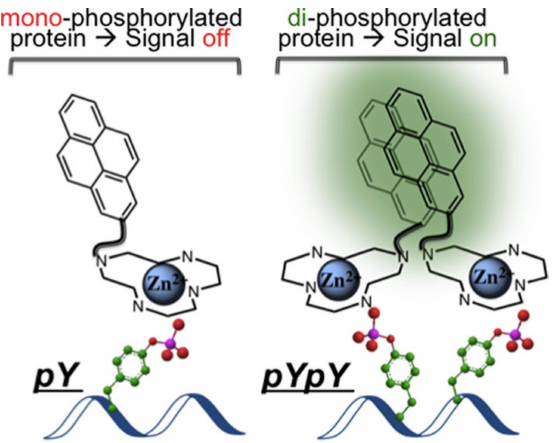
Figure 5. Schematic representation for the detection of diphosphorylated protein sites [35].